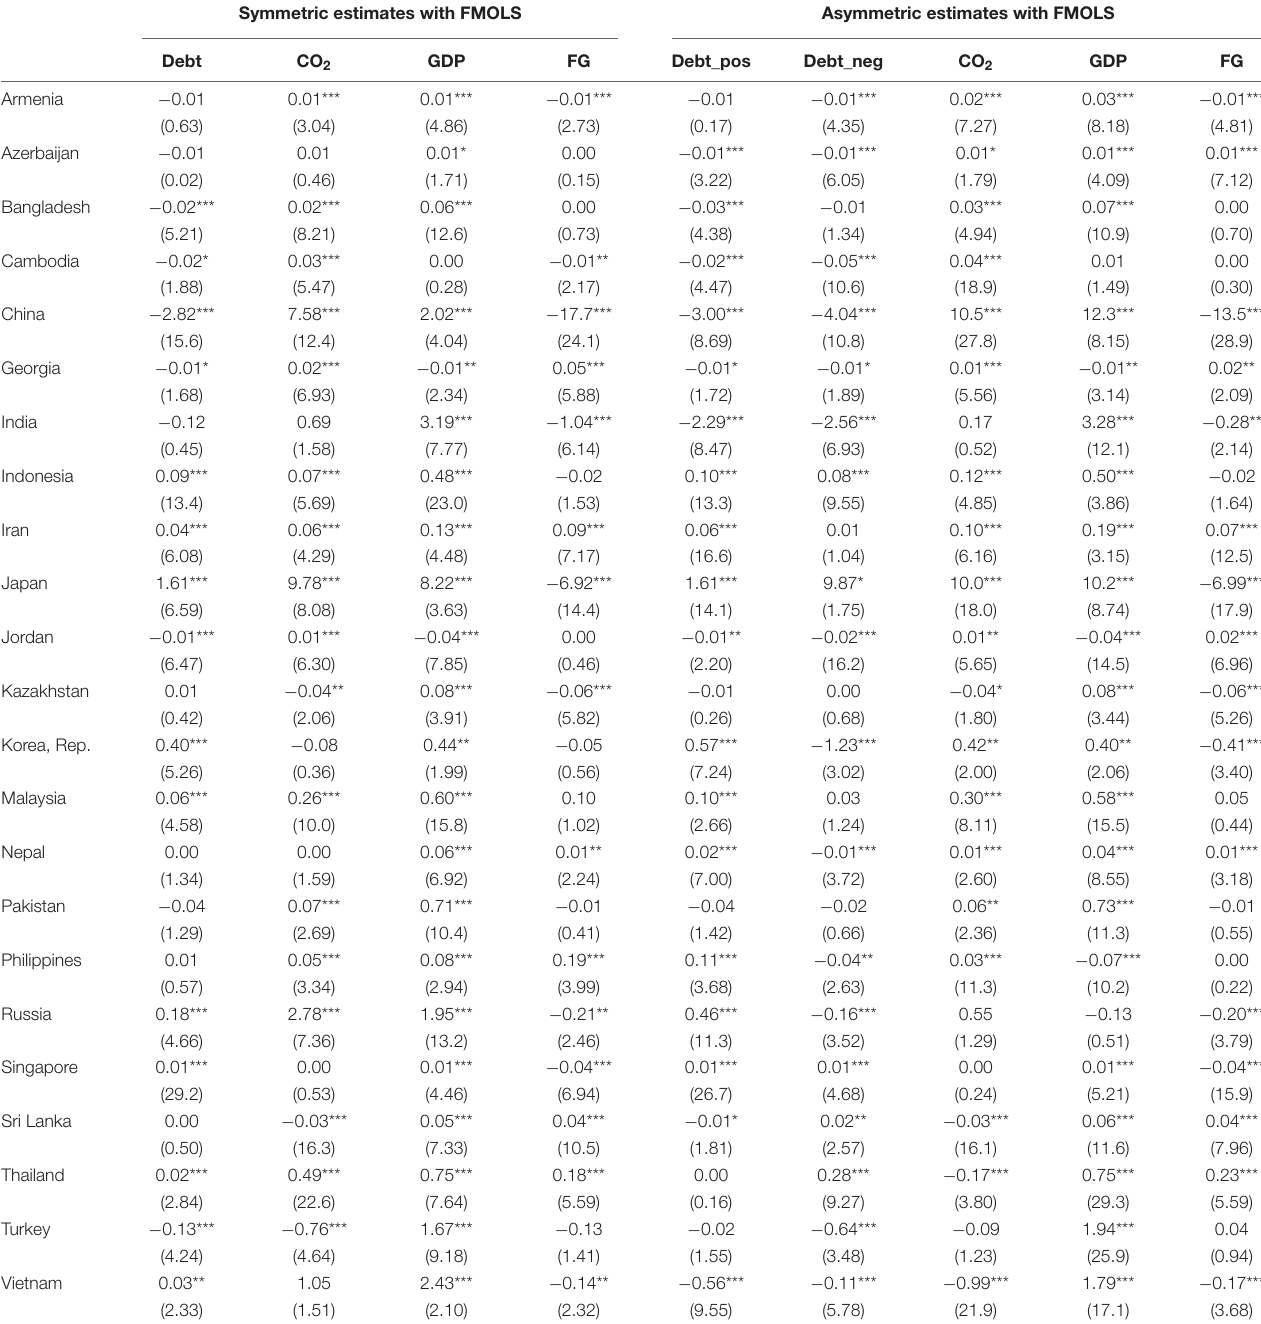
TABLE 5 | Symmetric and asymmetric results of FMOLS long-run